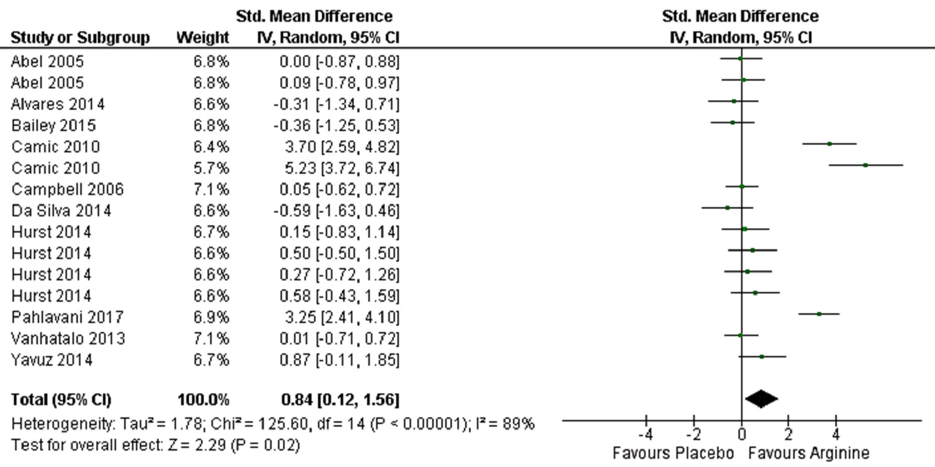
Figure 6. Forest plot comparing the effects of arginine supplementation on aerobic ( ≤ VO 2 max) performance.